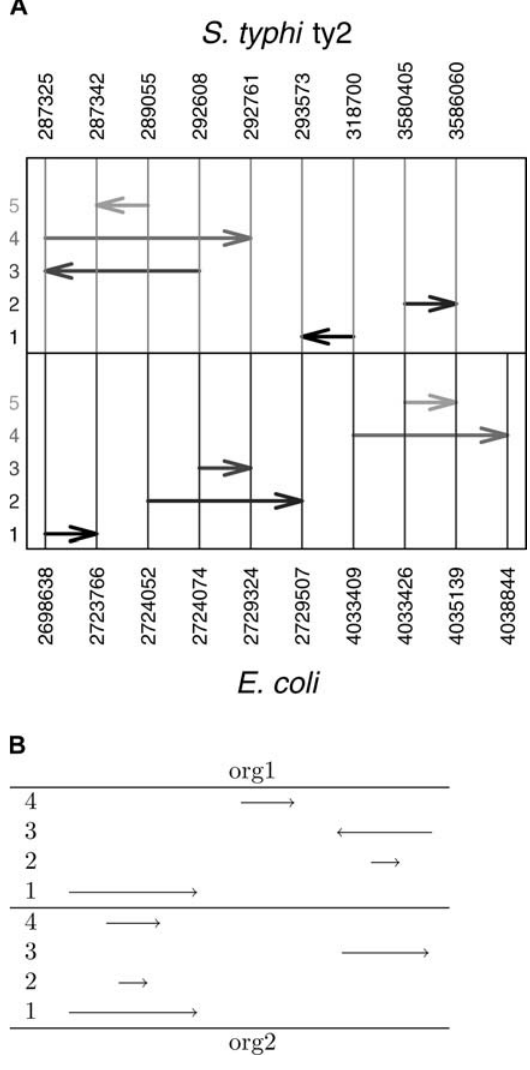
Figure 2. Schematic Examples of Situations That May Be Encountered While Clustering Entries of the Comprehensive Table (Steps 2 and 3 in the Mapping Phase) An entry is represented as two arrows having the same label, one in the top and one in the bottom panels. Labels for the arrows are given on the left side. The relative direction of identically labeled arrows represents the relative orientation of the corresponding segments. (A) A real example from the comparison of E. coli versus S. typhi ty2 demonstrating the difficulty of identifying the consecutive entry. In the top (bottom) panels, the positions of the segments in S. typhi ty2 ( E. coli ) are given. Arrows having the same label are drawn with identical grayscale color. The significantly overlapping entries, e.g . , 2 and 3 in E. coli, correspond to rDNA operons, of which there are seven units in each organism. Each of these seven units have a hit overlapping, for example Entry 2 in both top and bottom panels. For the sake of clarity, the figure demonstrates only a part of the hits and is schematic (not to scale). (B) Illustration of nuisance cross-overlaps and inparalogs. Entry 2 overlaps with Entry 1 in org1 and with Entry 3 in org2. Assuming that both overlaps are long enough and that Entry 2 is significantly shorter than either Entry 1 or Entry 3, Entry 2 is considered as a nuisance cross- overlap. On the other hand, Entry 4 overlaps Entry 1 in org2, but does not overlap with other entries in org1, and hence is not a nuisance cross- overlap. Assuming the length of Entry 1 is significantly greater than that of Entry 4, Entry 1 is considered to be the positional ortholog, while Entry 4 is considered to be the